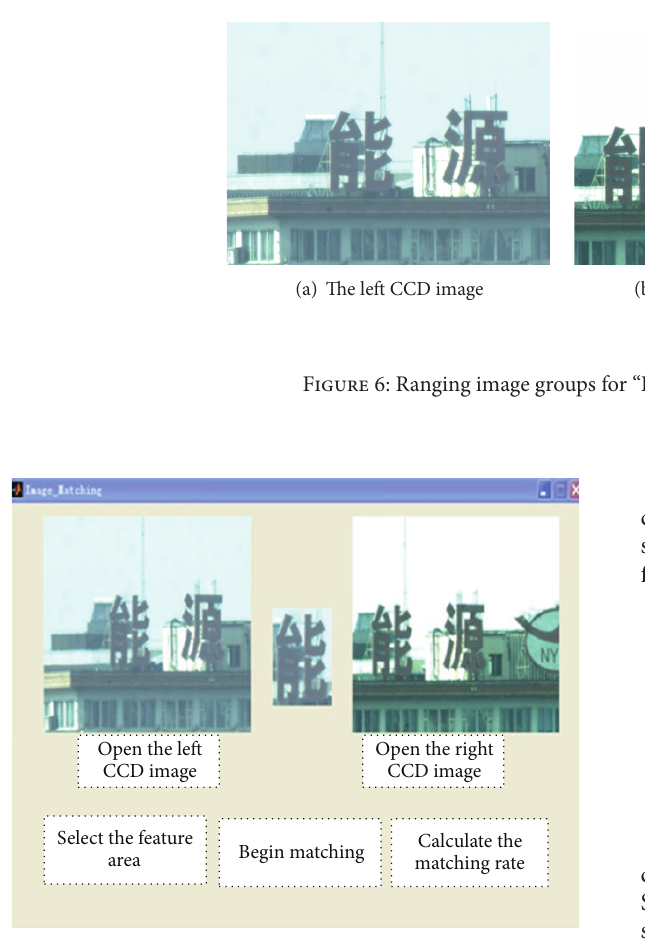
Figure 7: Software interface of image